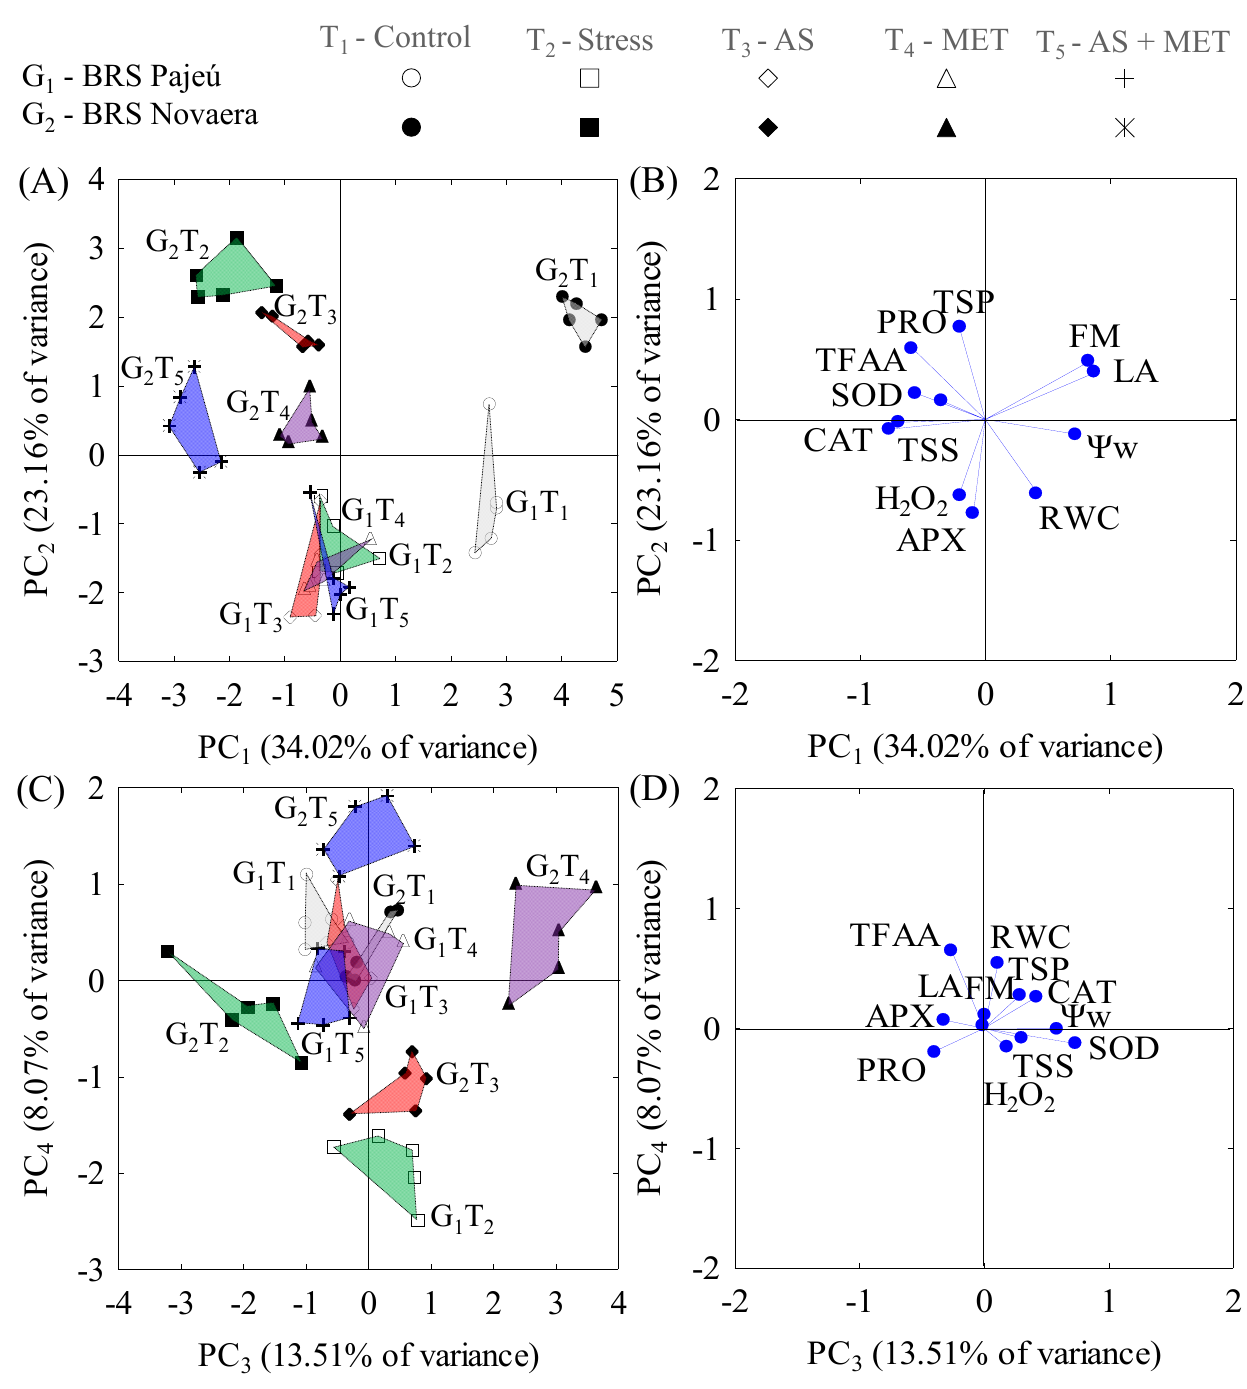
Figure 1. Two-dimensional projection of the interactions between genotypes and treatments ( A , C ) and between the correlation coefficients of the variables ( B , D ) with the first four principal components (PCs 1, 2, 3, and 4) eight days after the application of